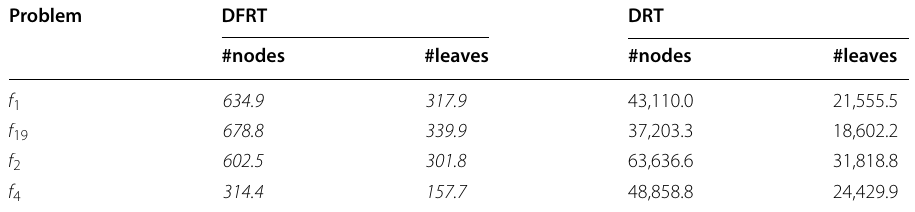
Table 6 Average complexity of the models obtained by DFRT and DRT for the synthetic